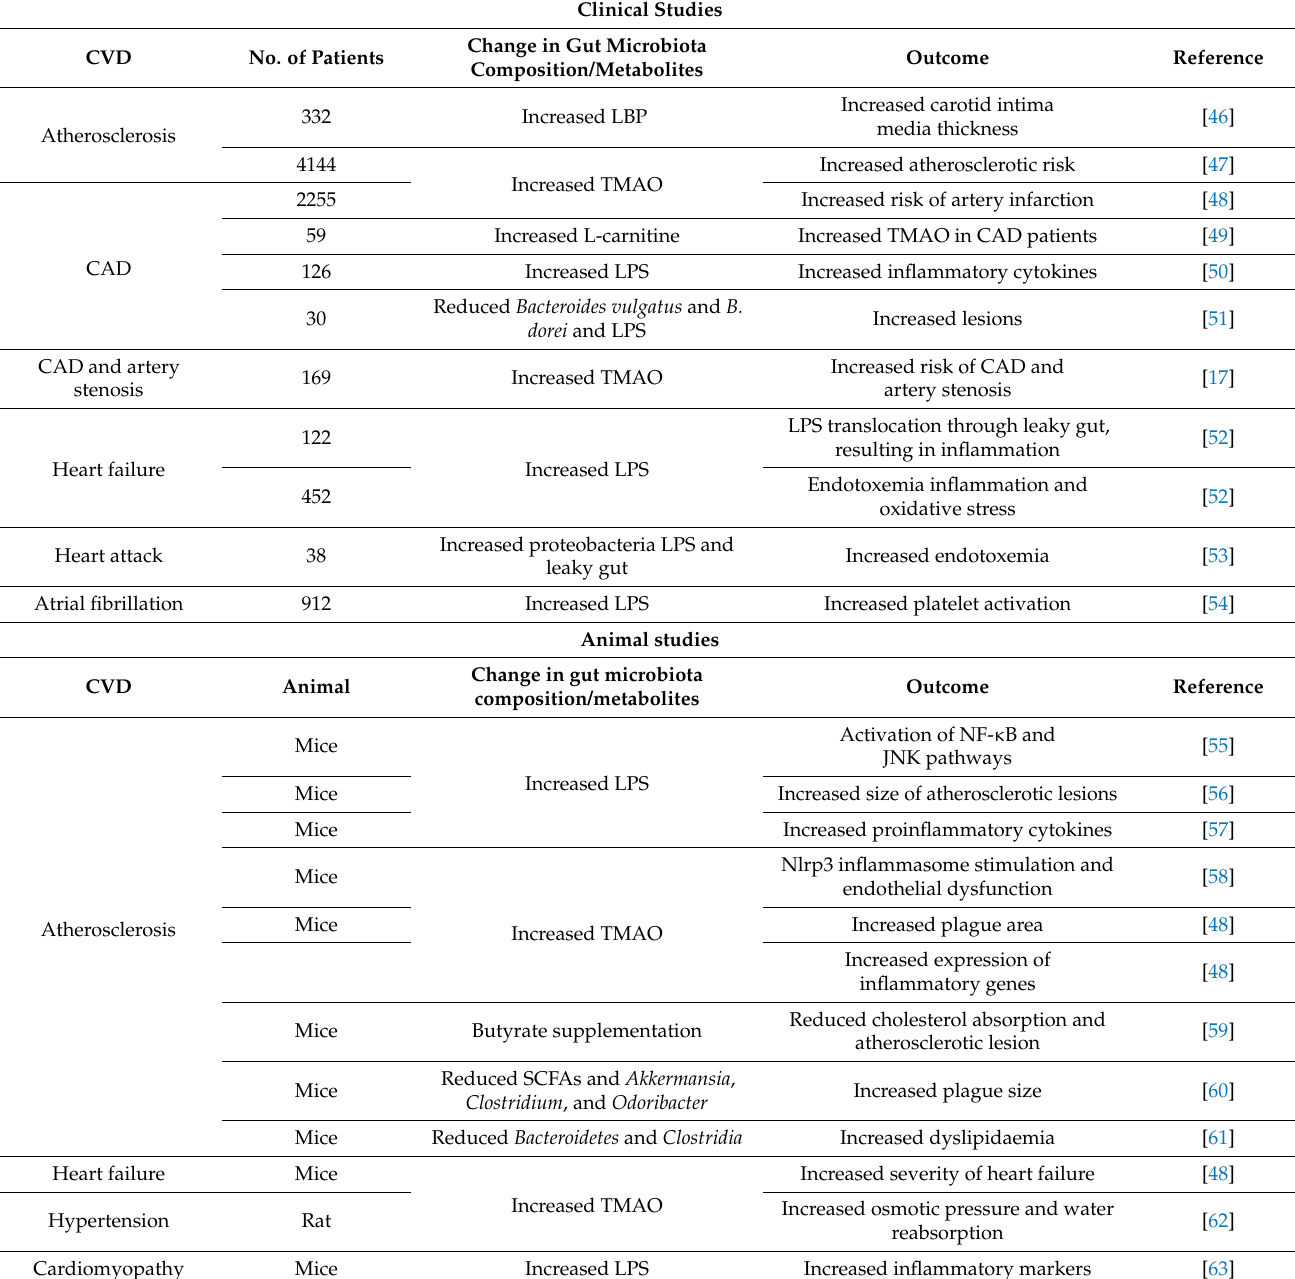
Table 2. Summary of trials explored connections between gut microbiota and